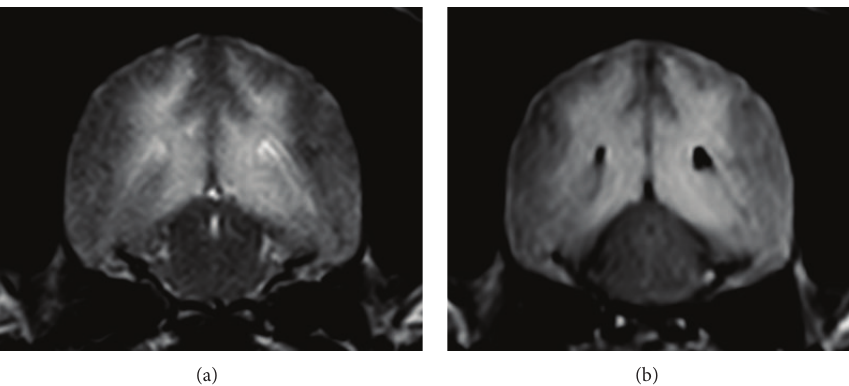
Figure 2: (a) T2-weighted (TR = 3720 ms, TE = 90 ms, slice thickness = 3,5 mm), (b) FLAIR (TR = 4000 ms, TE = 100ms, TI = 1000 slice thickness = 3,5 mm) at the level of the rostral mesencephalon. There is bilateral and symmetric T2 and FLAIR hyperintensity of the parietal periventricular white matter and corona radiata. No mass effect is